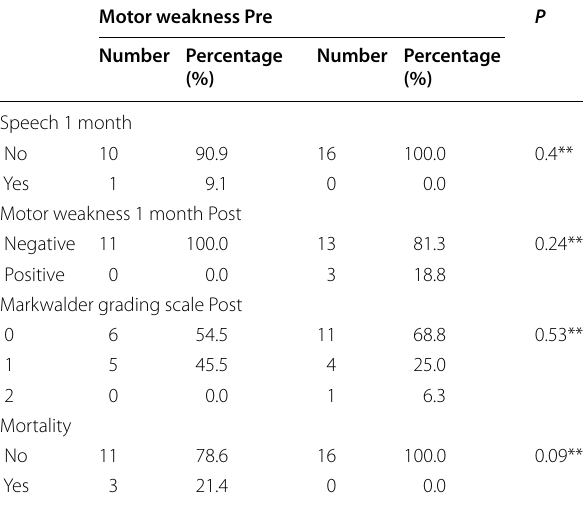
Table 8 Cases with and without preoperative motor weakness compared regarding final study outcomes